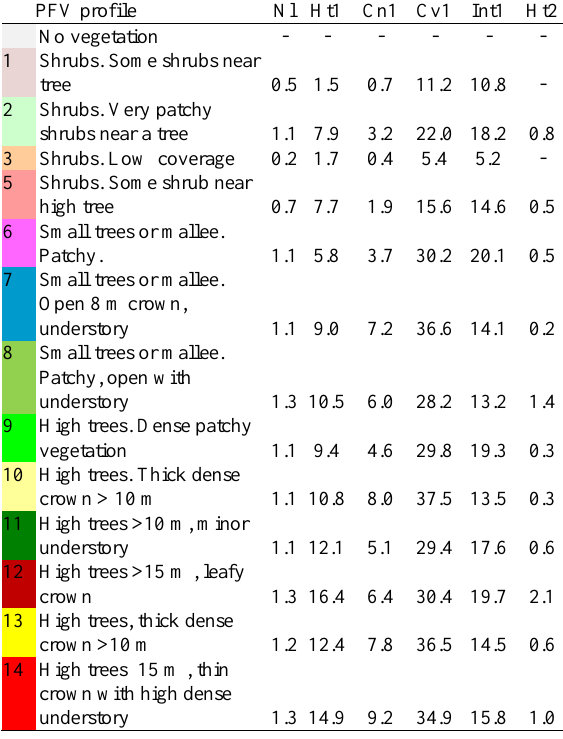
Table 1. Means of the top two canopy layer characteristics: number of canopy layers (Nl), height of dense top (Ht1) and second (Ht2) crown above ground, crown thickness (Cn1), ground coverage of crown (Cv1) and first and single return intensity (Int1) for each distinct vertical canopy